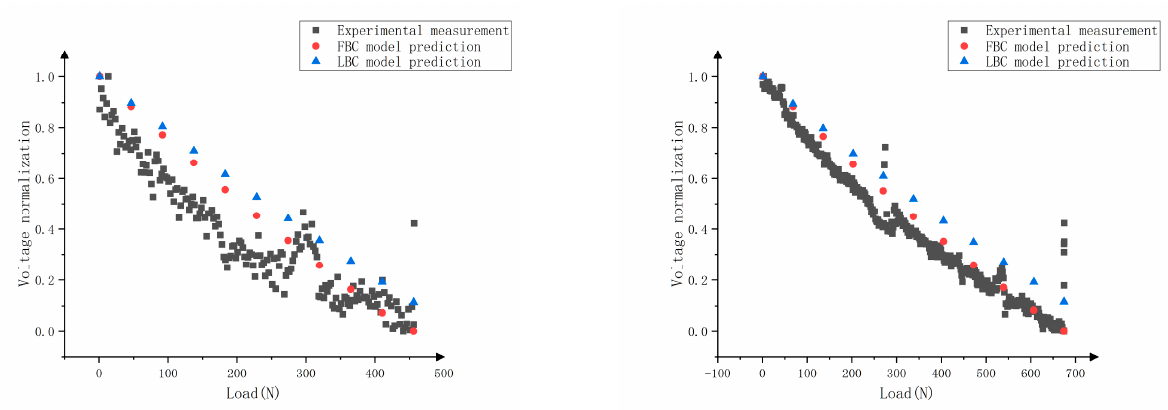
Figure 13. Normalized comparison between the simulation and experimental results. The ( left) picture shows the PTW structure, and the ( right) picture shows the TTW structure.